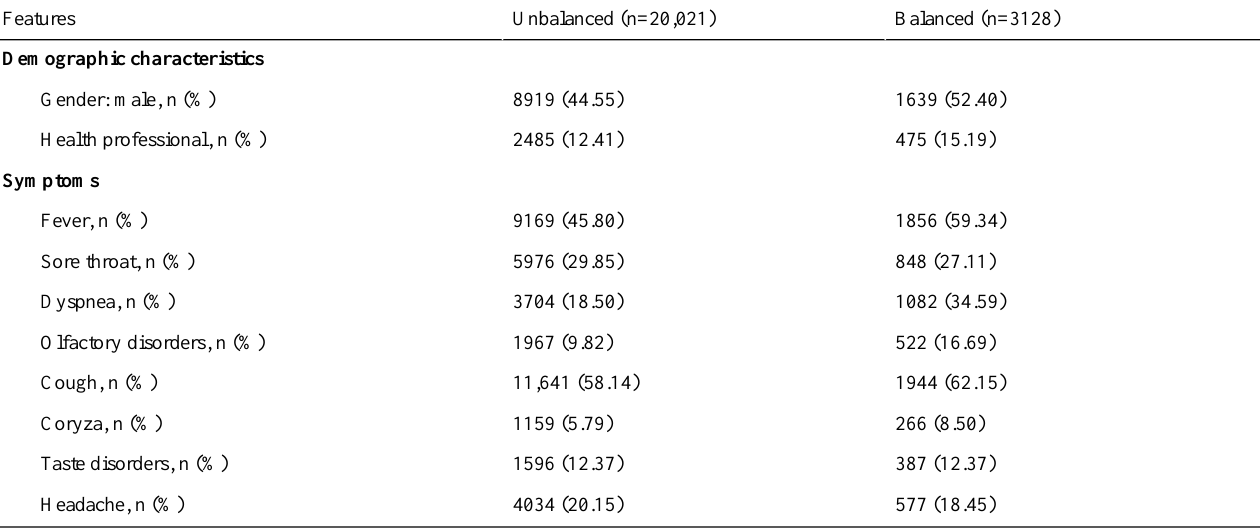
Table 1. Demographic and symptoms from patients who are symptomatic of both test type data